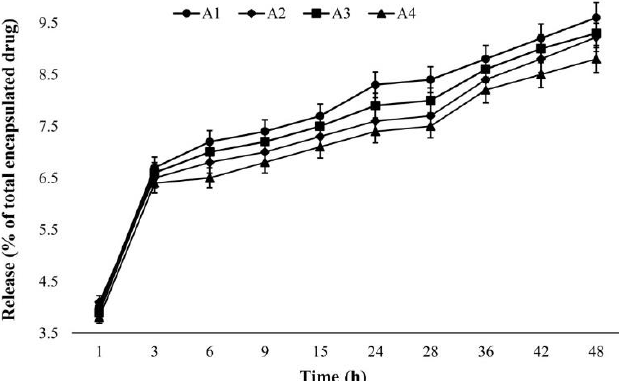
Figure 2. The cumulative cisplatin release percentage versus time for the A1 (0.25% w / v PEG concentration, room temperature), A2 (0.25% w / v PEG concentration, 65 °C), A3 (1.0% w / v PEG concentration, room temperature), and A4 (1.0% w / v PEG concentration, 65 °C) batches synthesized using an anionic polymerization technique at different time intervals. The results are expressed as mean ± 5% values from three independent experiments.